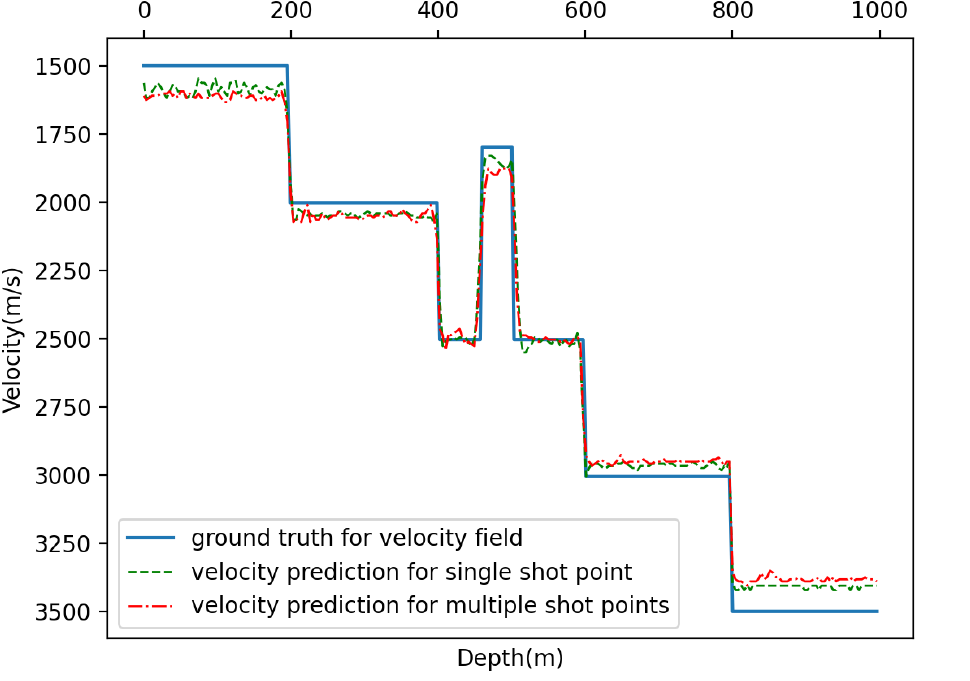
Figure 9. Prediction for velocity field and anomaly in velocity model with one anomaly and no fault.